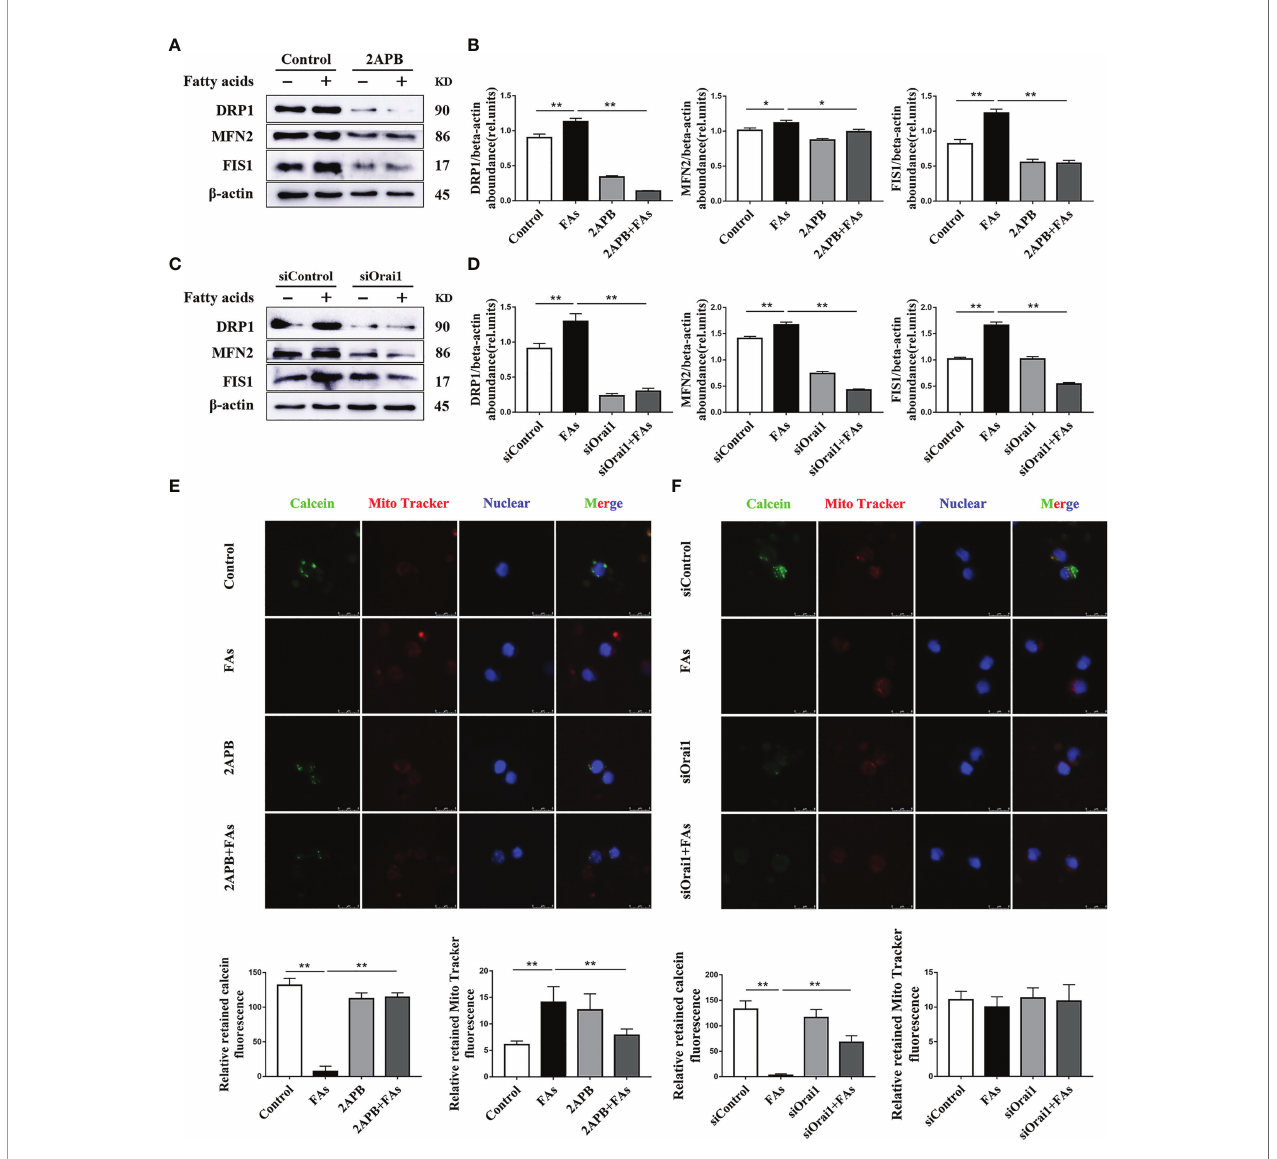
FIGURE 8 | ORAI1 levels affect the expression of mitochondrial dynamics-related protein and autophagy-related protein. CD4 + T cells were sorted from spleens from 1-d old calves and stimulated with 2APB or siORAI1 before FAs treatment with 12 h (A) Western blot analysis of mitochondrial dynamics-related protein in treatment with 2APB (n = 4 per group). (B) Relative abundance of mitochondrial dynamics-related protein in treatment with 2APB (n = 4 per group). (C) Western blot analysis of mitochondrial dynamics-related protein in treatment with siORAI1 (n = 4 per group). (D) Relative abundance of mitochondrial dynamics-related protein in treatment with siORAI1 (n = 4 per group). (E) Opening of mPTP was analyzed in conditions of CD4 + T cells treatment with 2APB (n = 3 per group; 3 random fi elds per group; scale bars, 8 m m). (F) Opening of mPTP was analyzed in conditions of CD4 + T cells treatment with siORAI1 (n = 3 per group; 3 random fi elds per group; scale bars, 8 m m). The data of the control were used to normalize other treatments. Comparisons among groups were calculated using a one-way ANOVA with a Duncan correction. The data presented are the mean ± SEM, *P ≤ 0.05, **P ≤ 0.01 indicate differences from control or FAs